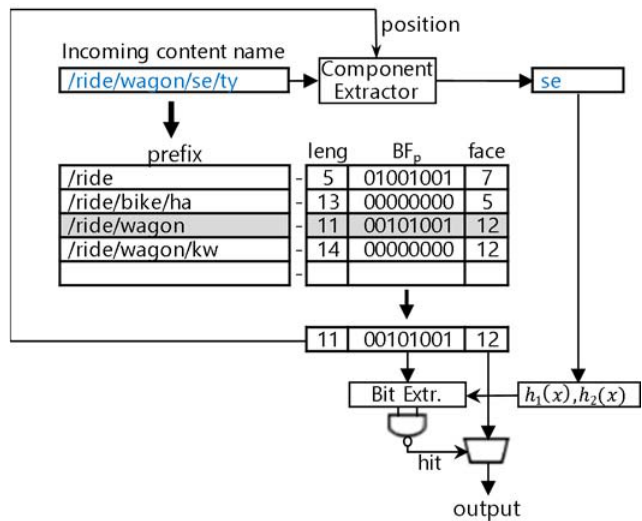
Figure 7. The architecture of a Bloom filter-based route prefix cache.